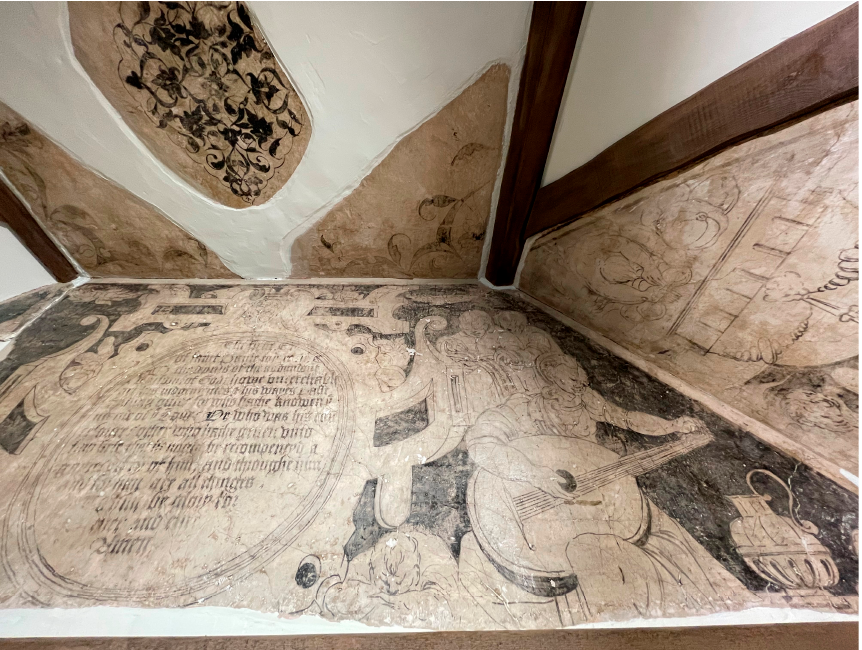
Figure 3. Anonymous, wall painting depicting Music-Making from 34 Upper High Street Thame, c.